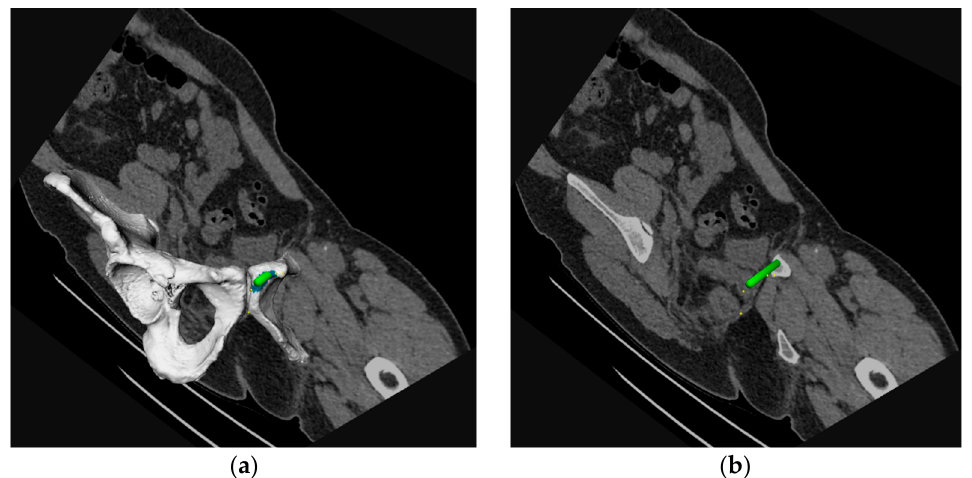
Figure 1. ( a ) A three-dimensional (3D) segmentation of the pelvic bone including a virtually placed column screw (green) with a single slice of the corresponding computer tomography (CT)-scan. ( b ) The position of the screw was assessed by scrolling through the slices of the CT scan.